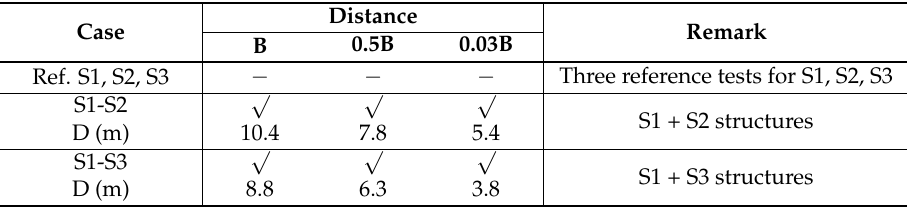
Table 3. Experimental